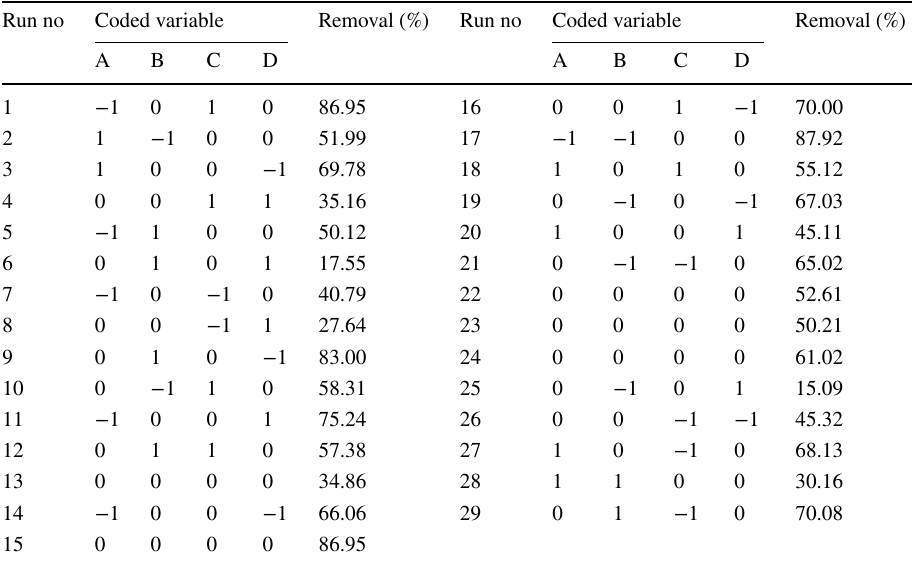
Table 2 BBD matrix for MG removal by Fe 3 O 4 /SC ncs